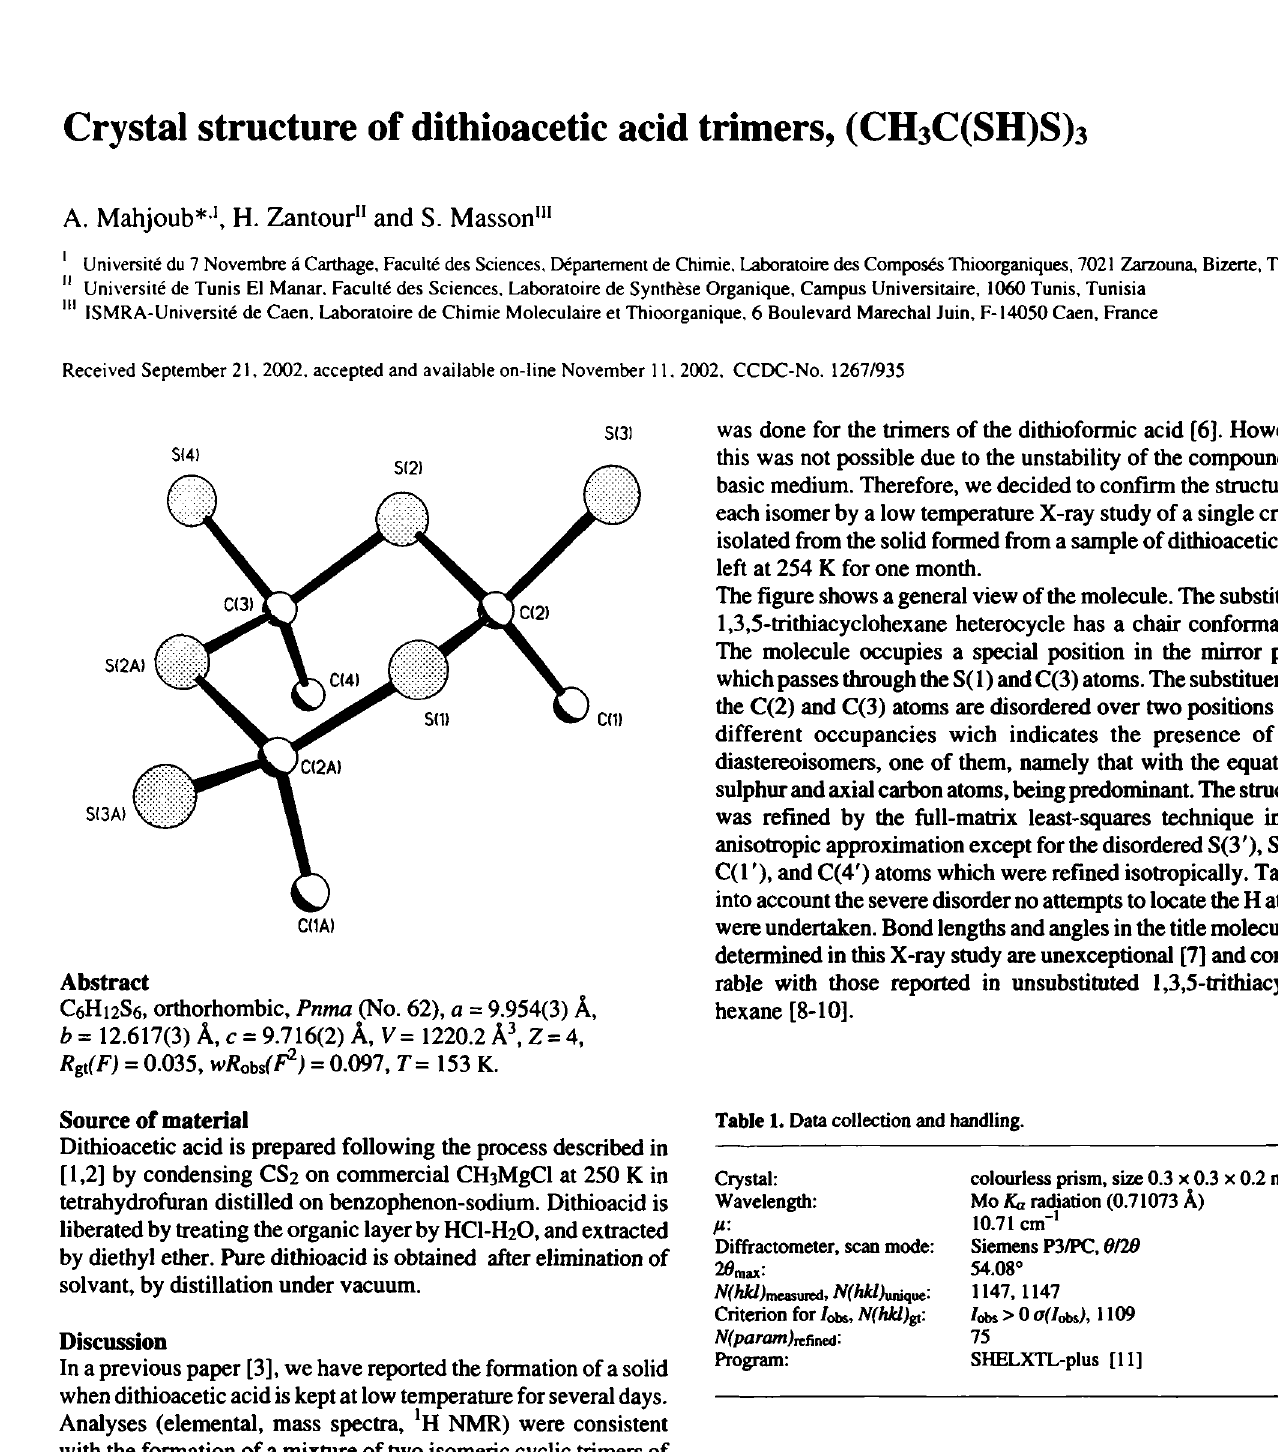
Table 2. Atomic coordinates and displacement parameters (in Â 2